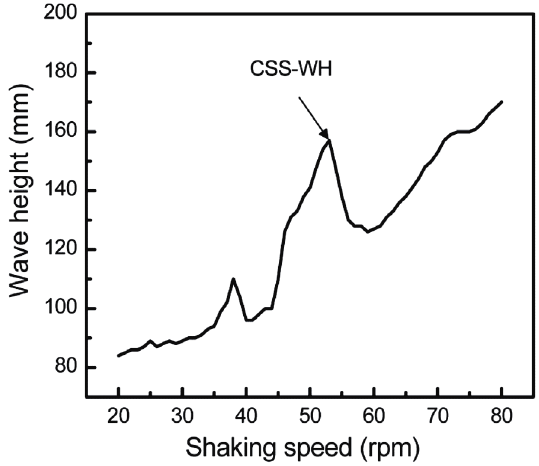
Fig. 5: A typical definition of CSS-WH